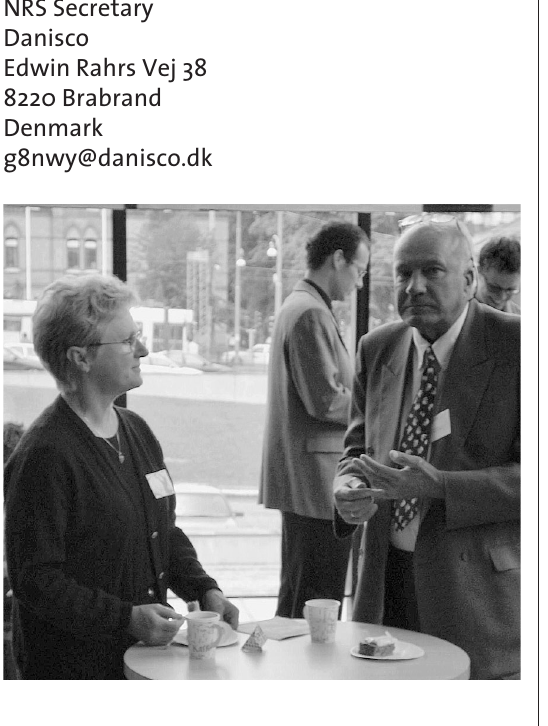
Figure 6: from left to